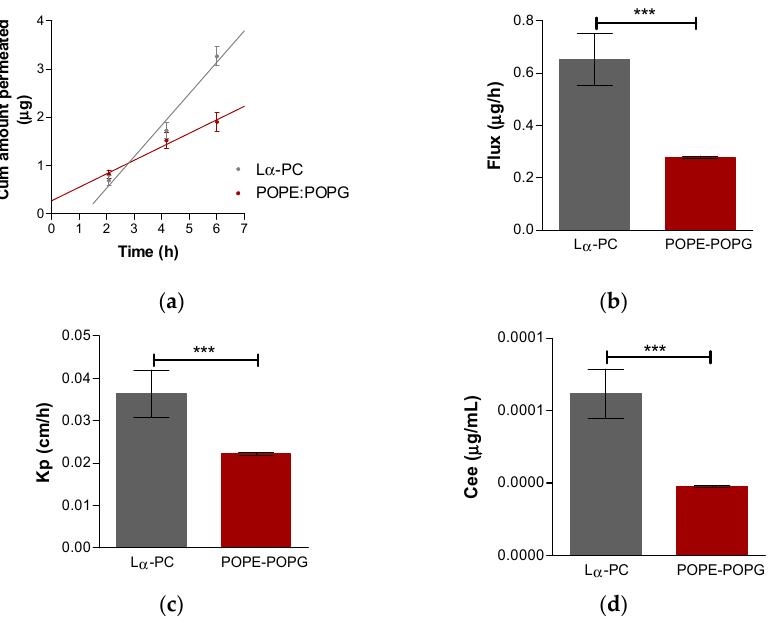
Figure 7. Ex vivo transscleral permeation. ( a ) Baricitinib permeation profile: baricitinib cumulative amount permeated ( μ g) vs. time (h); ( b ) baricitinib flux for each liposome; ( c ) baricitinib amount retained in the scleral tissue; ( d ) theoretical plasma concentration at the steady-state in humans. Results are expressed by mean ± SD (n = 5). L α -PC = L- α -phosphatidylcholine; POPE:POPG = 1- palmitoyl-2-oleoyl-phosphatidylethanolamine: 1-Palmitoyl-2-oleoyl-sn-glycerol-3-phosphoglycerol (3:1, mol/mol). t -test analysis with statistically significant difference: *** = p < 0.0001.